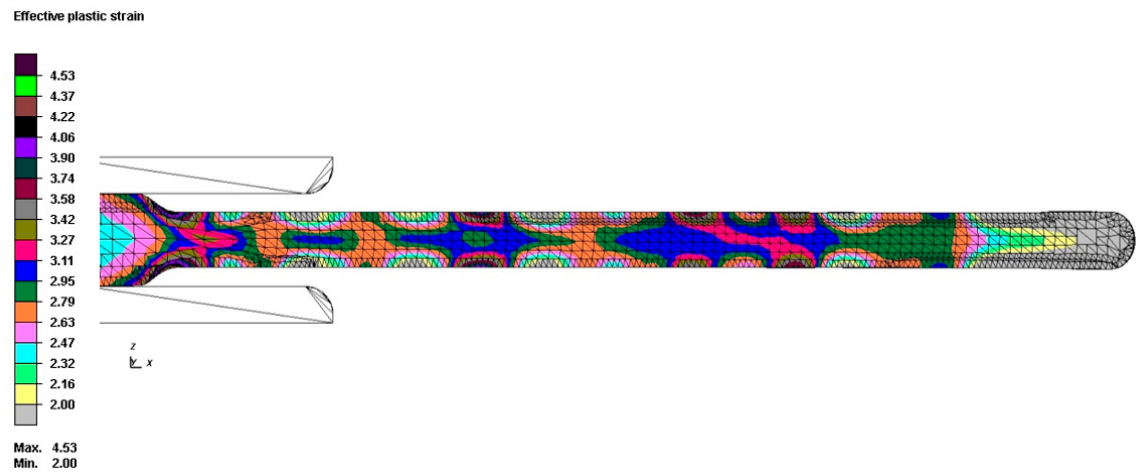
Figure 4. Effective plastic strain distribution calculated by numerical simulation of forging the plate with 310 mm of thickness from the P40N slab ingot.